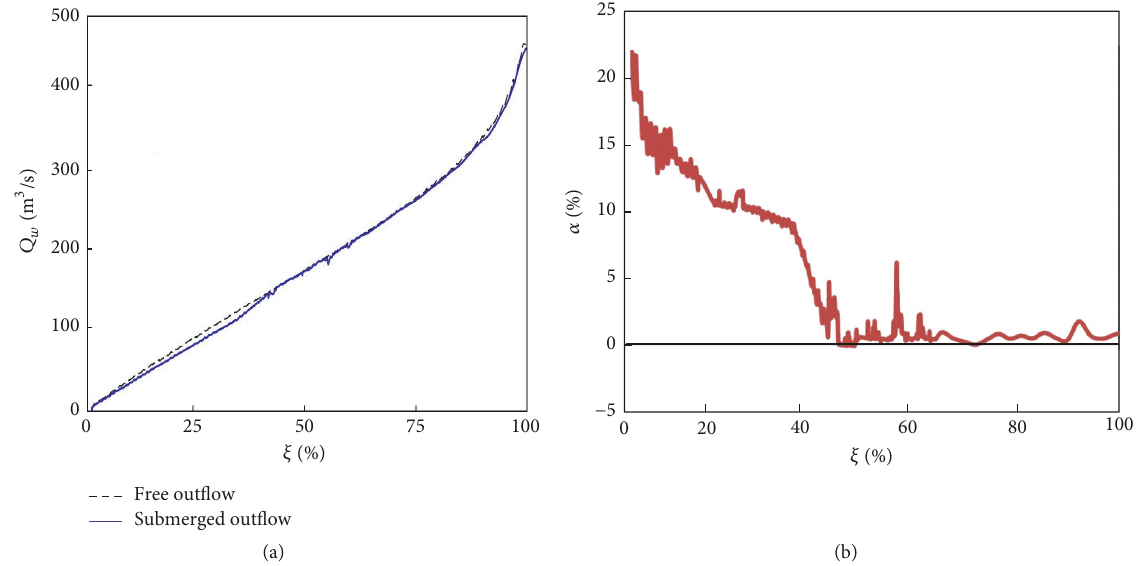
Figure 11: Differences between free and submerged outflow, 𝑄 𝑤 and 𝛼 as a function of 𝜉